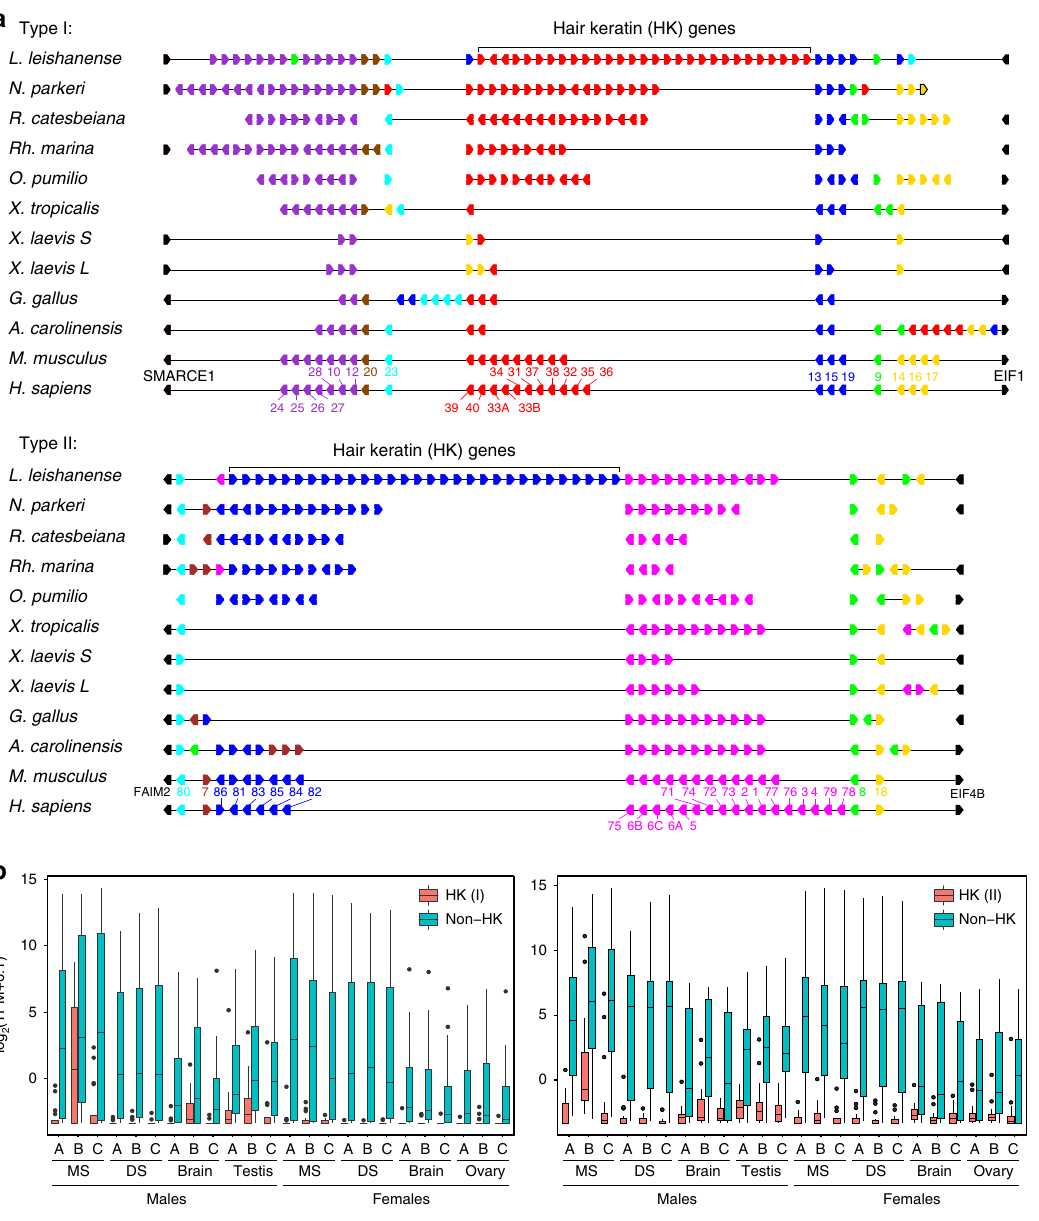
Fig. 3 Genomic distribution and expression pattern of the keratin gene family. a Genomic organization of type I and type II α -keratin genes in different species. Polygon arrows indicate the direction of keratin genes in the genome. Gene colors are marked based on homologous relationships with human keratin genes. Protein names in human are listed. b Box plots of the expression levels for HK genes and non-HK genes in different samples. The expression level was evaluated by log 2 (TPM + 0.1). For each boxplot of type I HK, n = 17 genes ’ mean expression values based on three biological replicates; for each boxplot of type I non-HK, n = 22 genes; for each boxplot of type II HK, n = 17 genes; for each boxplot of type II non-HK, n = 15 genes (Supplementary Data 4). The middle line of a box indicates the median (50 percentile) of the expression values for HK (red boxes) and non-HK (blue boxes) genes. The upper and lower terminal lines of a box represent the 25th and 75th percentiles, respectively. Lines extending vertically from the boxes (whiskers) indicate variability outside the upper and lower percentiles.